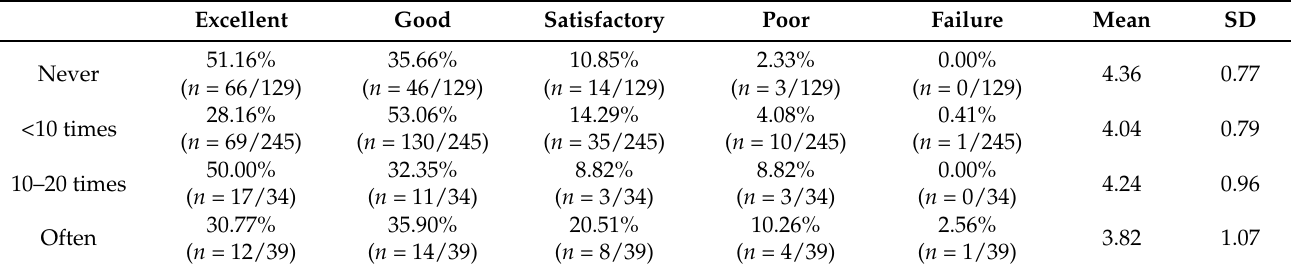
Table 5. The distribution of final course grades by frequency of student engagement in cheating.